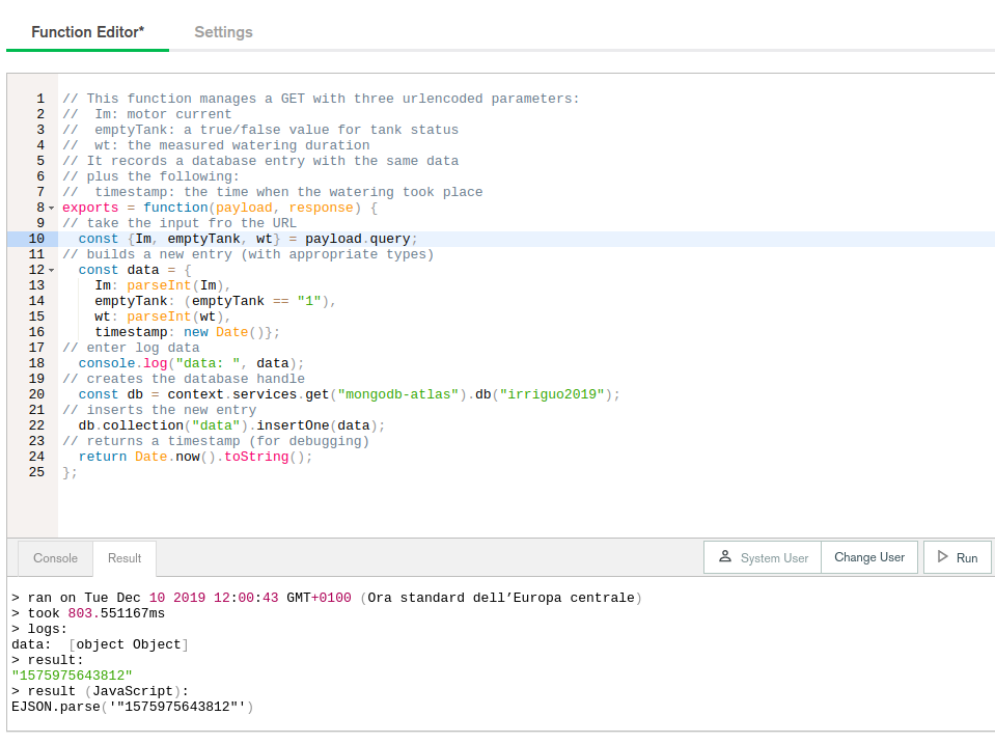
Figure 5. The JavaScript source of the report Stitch Function as displayed in the IDE provided by the Atlas web